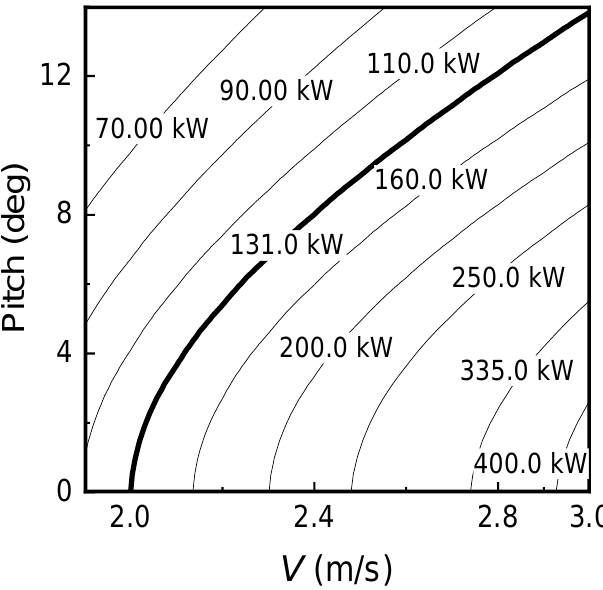
Figure 10. Output power of the turbine with varying pitch angles under various tidal velocities. For each tidal velocity greater than 2.0 m/s, there is an optimal pitch position to maintain the output power of the turbine at the rated value. The optimal pitch angles of the turbine corresponding to varying tidal velocities are shown in Figure 10. The optimum pitch angle has a significant nonlinear relationship with the tidal velocity. By fitting the relationship between the optimal pitch angle ( β ) and the tidal velocity ( V ) with the eight- degree polynomial, the change rate of the optimal pitch angle relative to the tidal velocity can be obtained, which is described as d β /d V , as shown in Figure 11. When the tidal velocity is in the range of 2~2.125 m/s, the optimal pitch angle increases rapidly with increased velocity, and the maximum value of d β /d V is approximately 55 deg/(m/s). The rate of the optimal pitch angle versus velocity decreases when V exceeds 2.125 m/s, and the value of d β /d V is approximately 15~10 deg/(m/s).